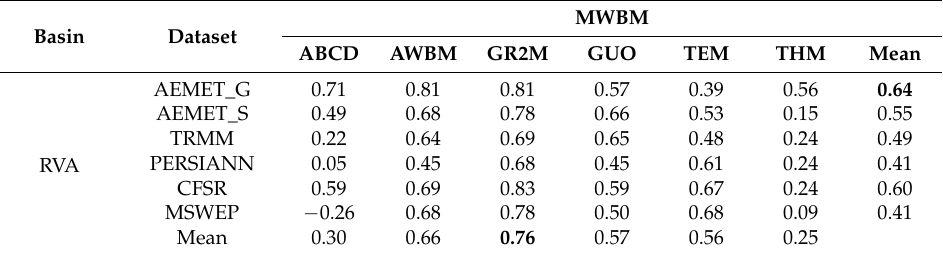
Table 6. Percentage difference between the total observed and modelled runoff (REV) of simulated streamflow for the different datasets using MWBMs (best results in bold).